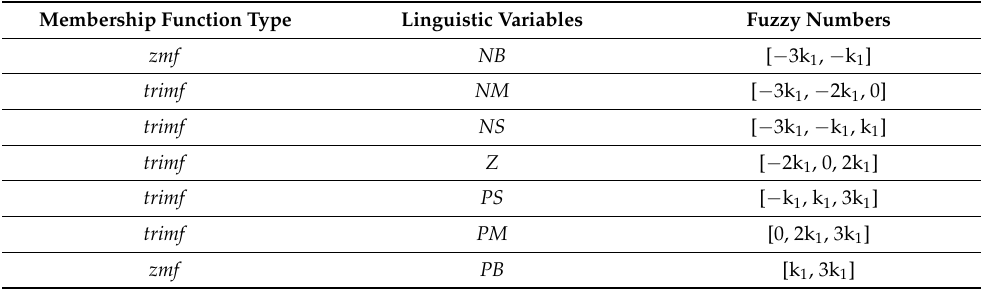
Table 4. Membership function, fuzzy set labels, and fuzzy numbers representation for Figure